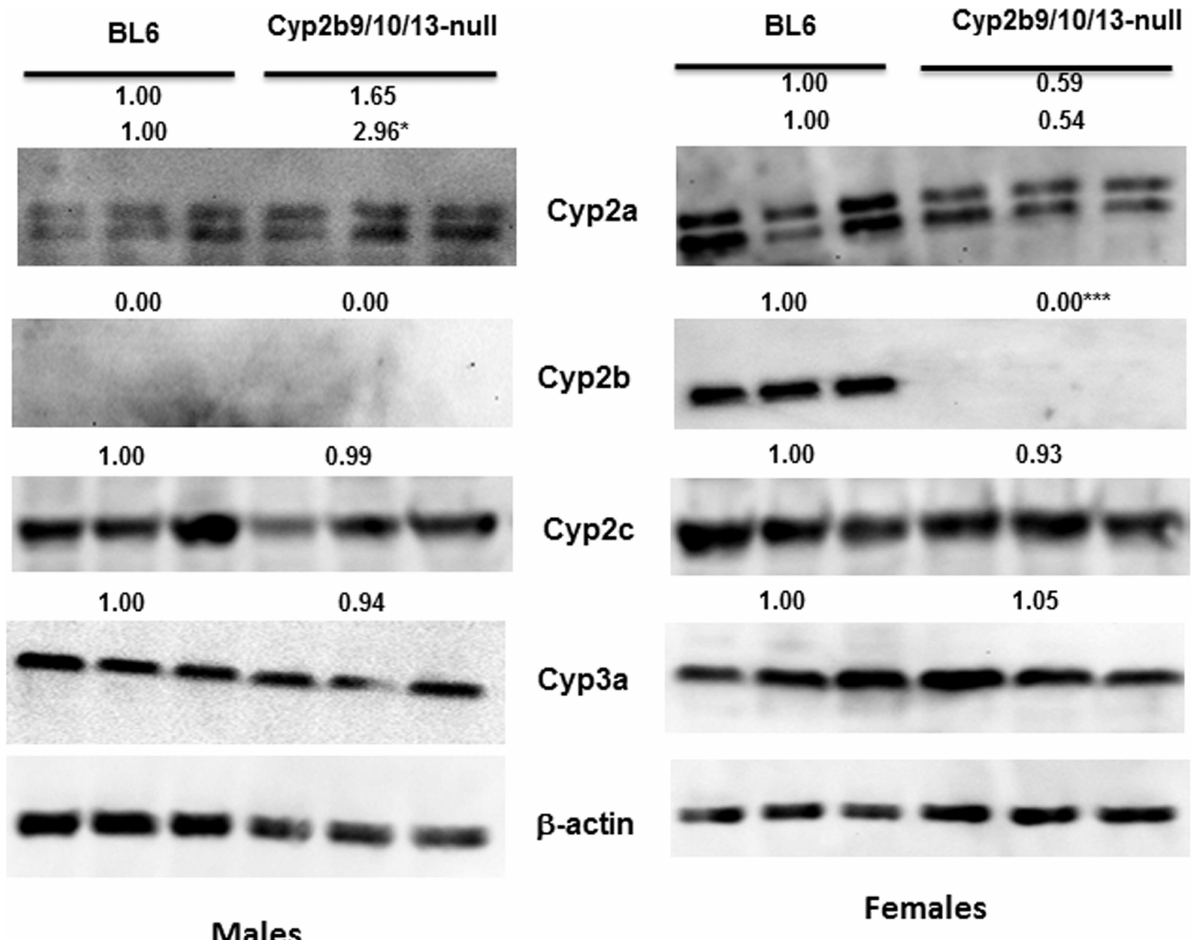
Fig 6. CYP protein expression in WT and Cyp2b9/10/13-null mice. Western blots of male and female Cyp2b9/10/13-null mice show significantchangesin CYP expressionrelative to their WT counterparts. Cyp2a isoforms show two bandsas Cyp2a22is 50kDain B6 mice and the other Cyp2a isoforms are 56 kDa. Results are expressedas relativemean of the WT comparedto CAR-nullmice of the same sex. Statistical differenceswere determined by Student’s t-tests (n = 3) with * (p < 0.05) *** (p < 0.001) indicatingsignificantdifferences.